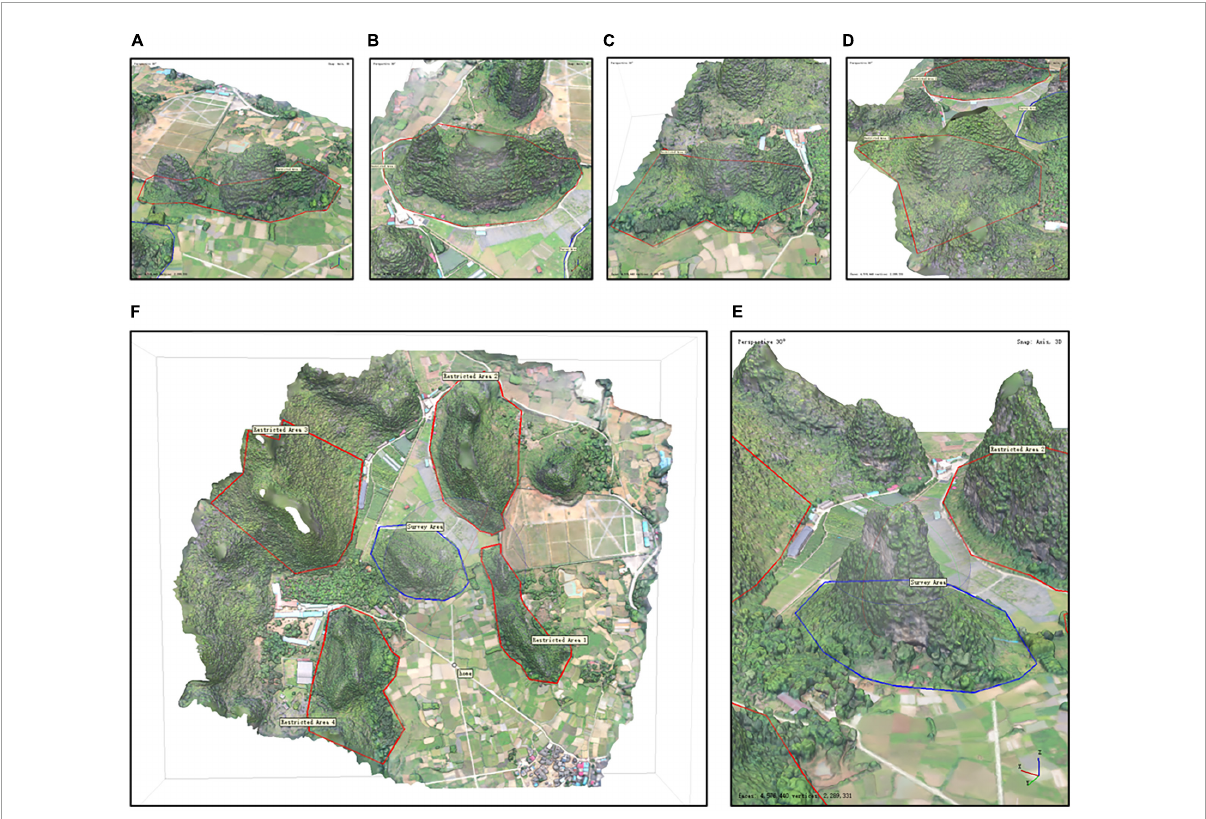
FIGURE3 Survey area and restricted area of the study area. The area with the red edge is the restricted area, and the area with the blue edge is the survey area. (A–D) Orientation of the cliff: east, south, west, and north, respectively. There are five areas in (F) , including four restricted area and one survey area. (E) The area with the widest view in the study